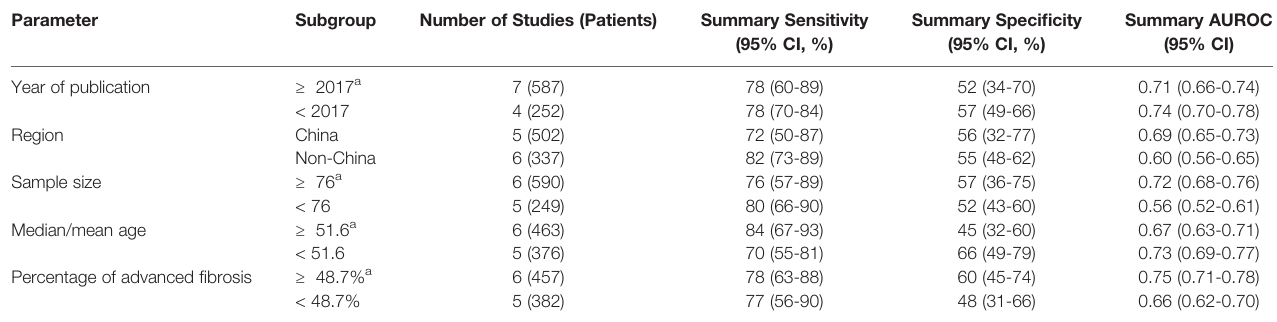
TABLE 4 | Subgroup analysis of APRI in prediction of advanced fi brosis. Parameter Subgroup Number of Studies (Patients) Summary Sensitivity